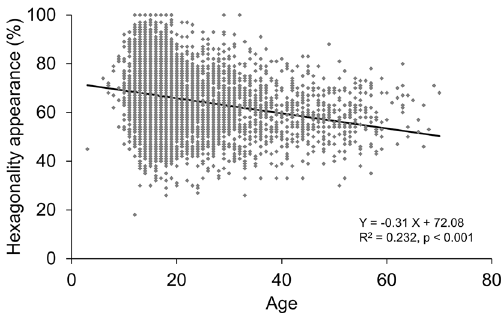
Figure 3. Association between the hexagonal appearance of corneal endothelial cell and age in ophthalmologically healthy Japanese. Based on the linear regression model, a significant weak negative association between the hexagonal appearance of corneal endothelial cell and age was observed (Y = − 0.31 X + 72.08, R 2 = 0.232, p < 0.001).